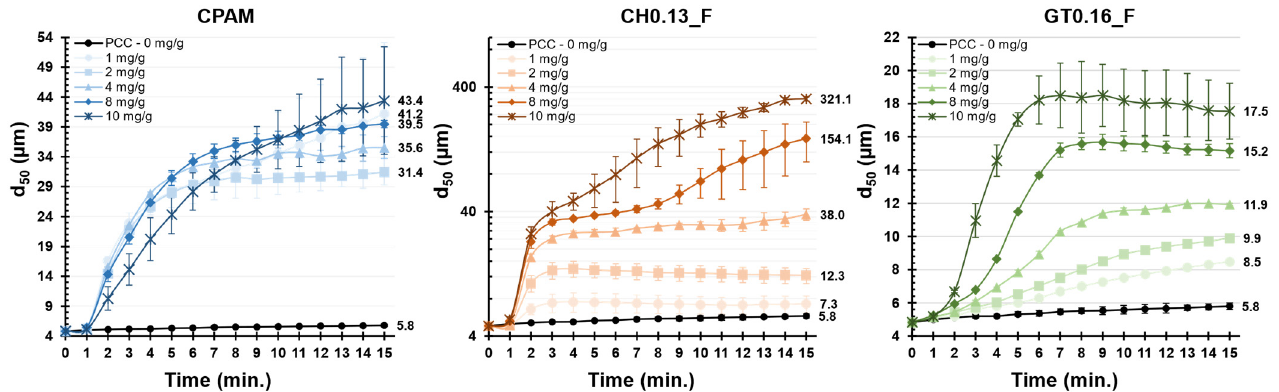
Figure 6. Median flocs size as a function of flocculation time for several concentrations of the best flocculants.